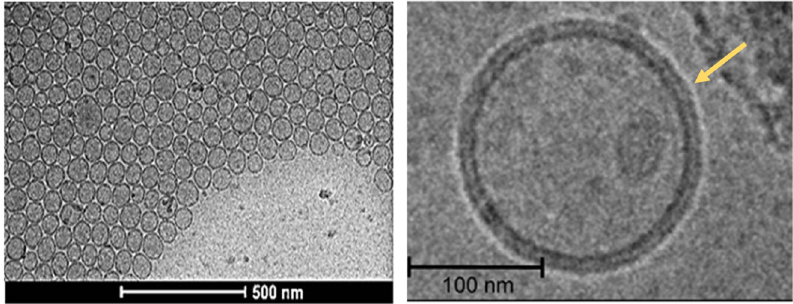
Figure 4. High-resolution Cryo-TEM images of liposomes [146]. Liposome lamellarity can be evaluated by 31 P-NMR [116]. Phospholipids in unilamel- lar liposomes can be characterized by a narrow-line spectrum, whereas multilamellar lip- osomes displayed wider peaks due to the restricted anisotropic molecular motions within multiple lipid layers